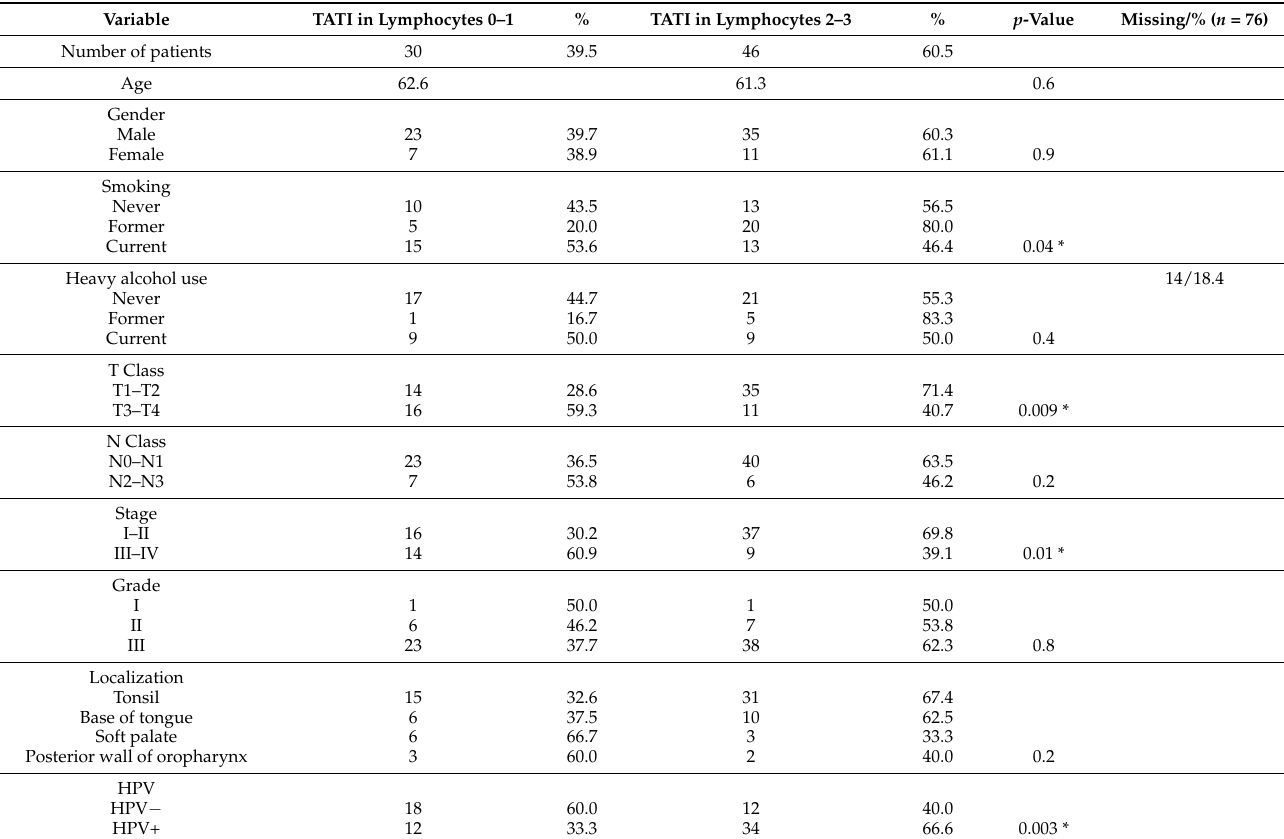
Table 4. Clinicopathological data according to TATI expression in tumor-adjacent